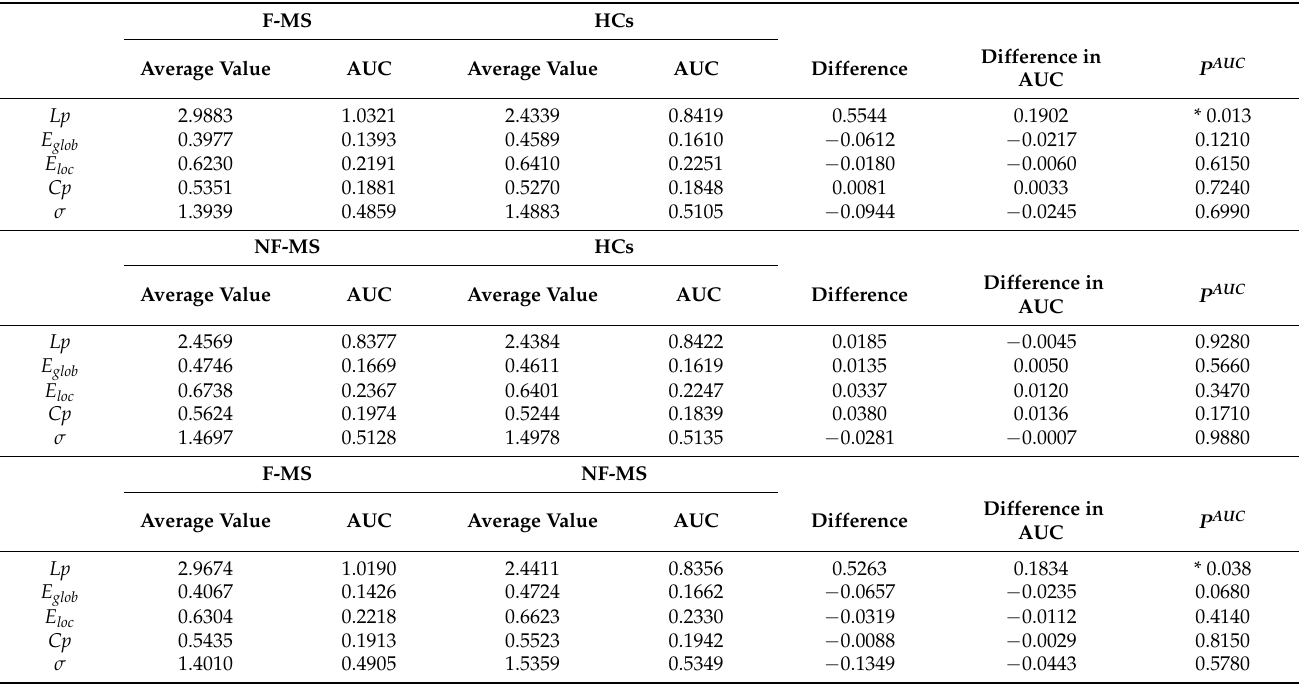
Table 3. Differences in the intrinsic thalamic global network in the F-MS, NF-MS, and HC